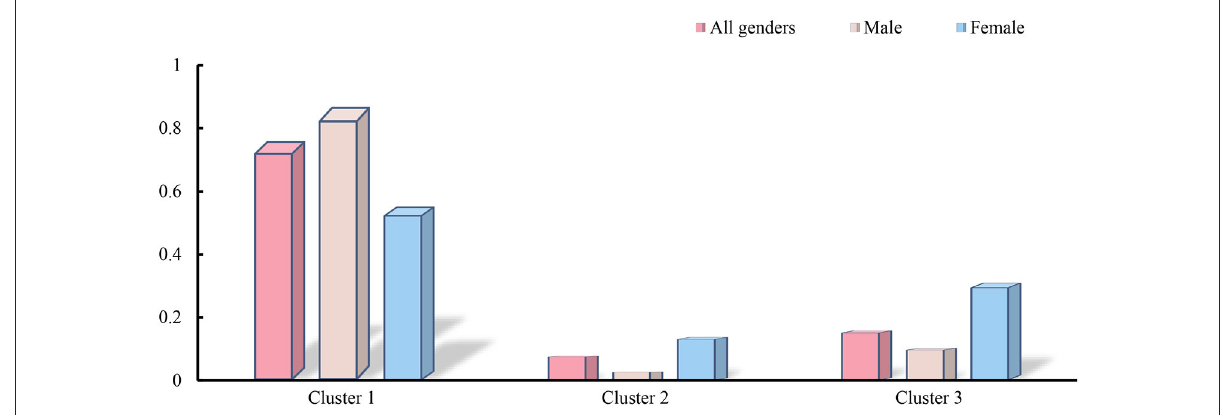
FIGURE3 The panel shows the independent contributions of the 3 clusters to the health utility values. Cluster1 include Sociodemographic factors, Cluster2 include Diseases factors and Cluster3 include Anthropometric indicators.